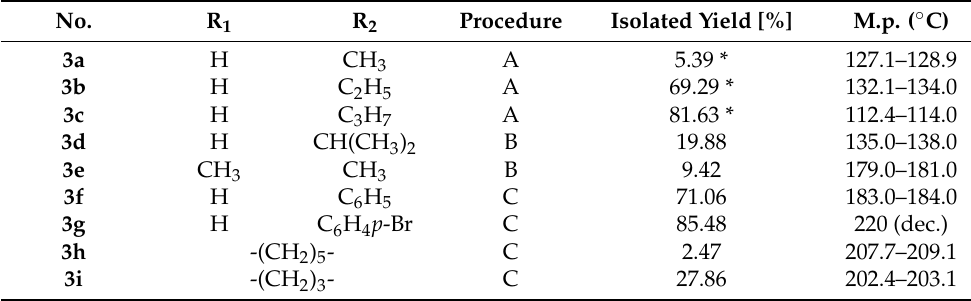
Table 1. The yields and melting points of 2-(cyclopentylamino)thiazol-4(5 H )-one.